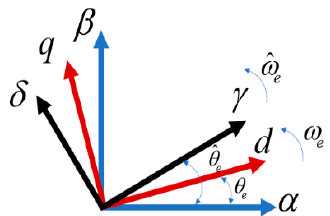
Figure 1. Real static coordinate ( α − β ) real rotational coordinate ( d-q ) and estimated rotational coordinate ( γ − δ ) for permanent magnet synchronous motor (PMSM) . u and u are stator voltage components in actual rotational frame, Where d q